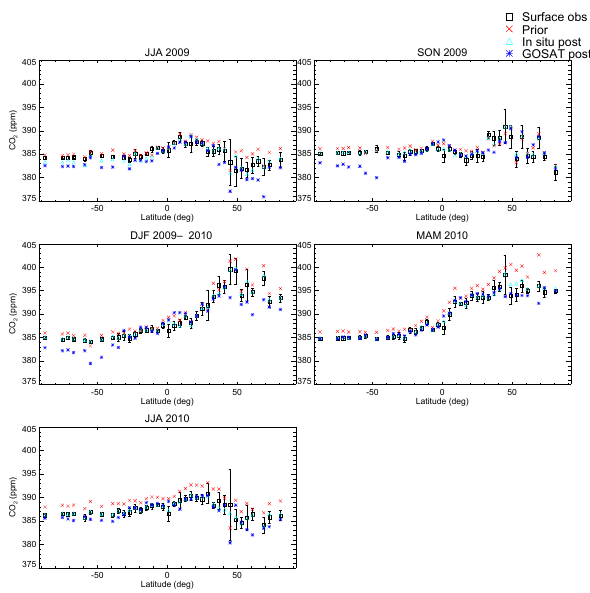
Figure 9. Latitudinal profiles of seasonal mean CO 2 mole fractions at surface sites for observations, prior, in situ only posterior, and GOSAT only posterior. Values are averaged in 4 ◦ bins. Error bars account for the spread in the observations within each season and bin as well as the uncertainty in each